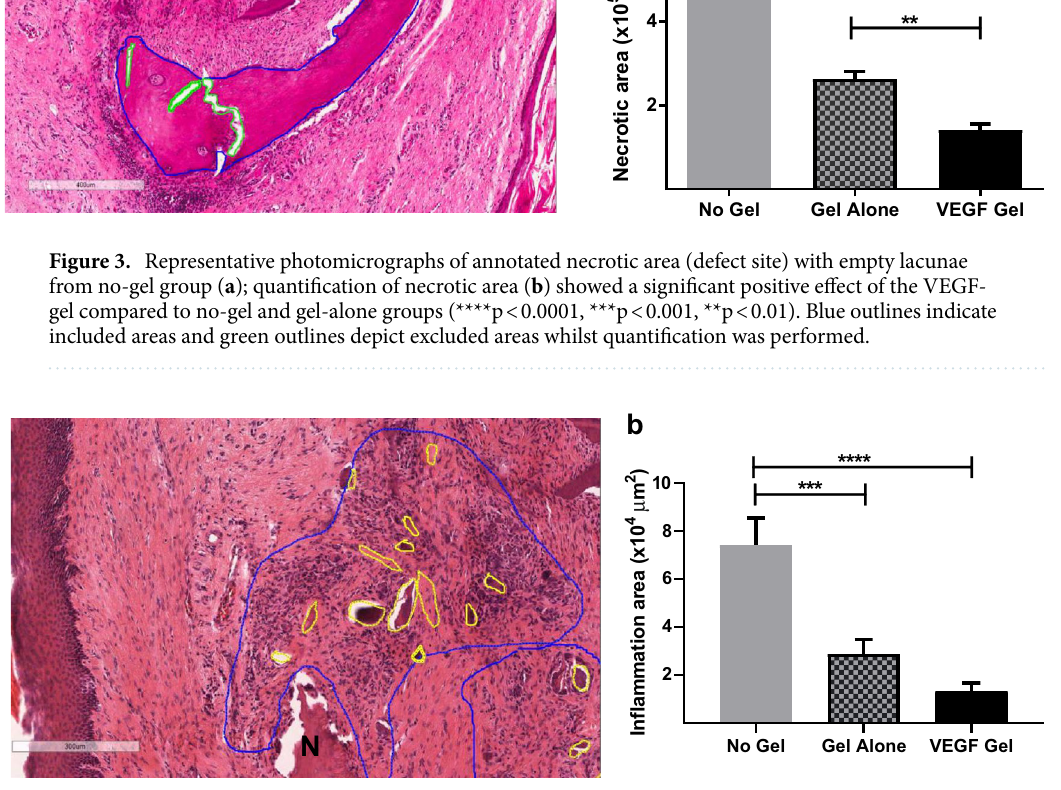
Figure 4. Representative photomicrograph of annotated inflammatory infiltrate around the necrotic (N) area in the defect site from no-gel group ( a ). Quantification ( b ) showed a significant reduction of inflammatory infiltrate in the VEGF-gel compared to no-gel and gel-alone groups (****p < 0.0001, ***p <